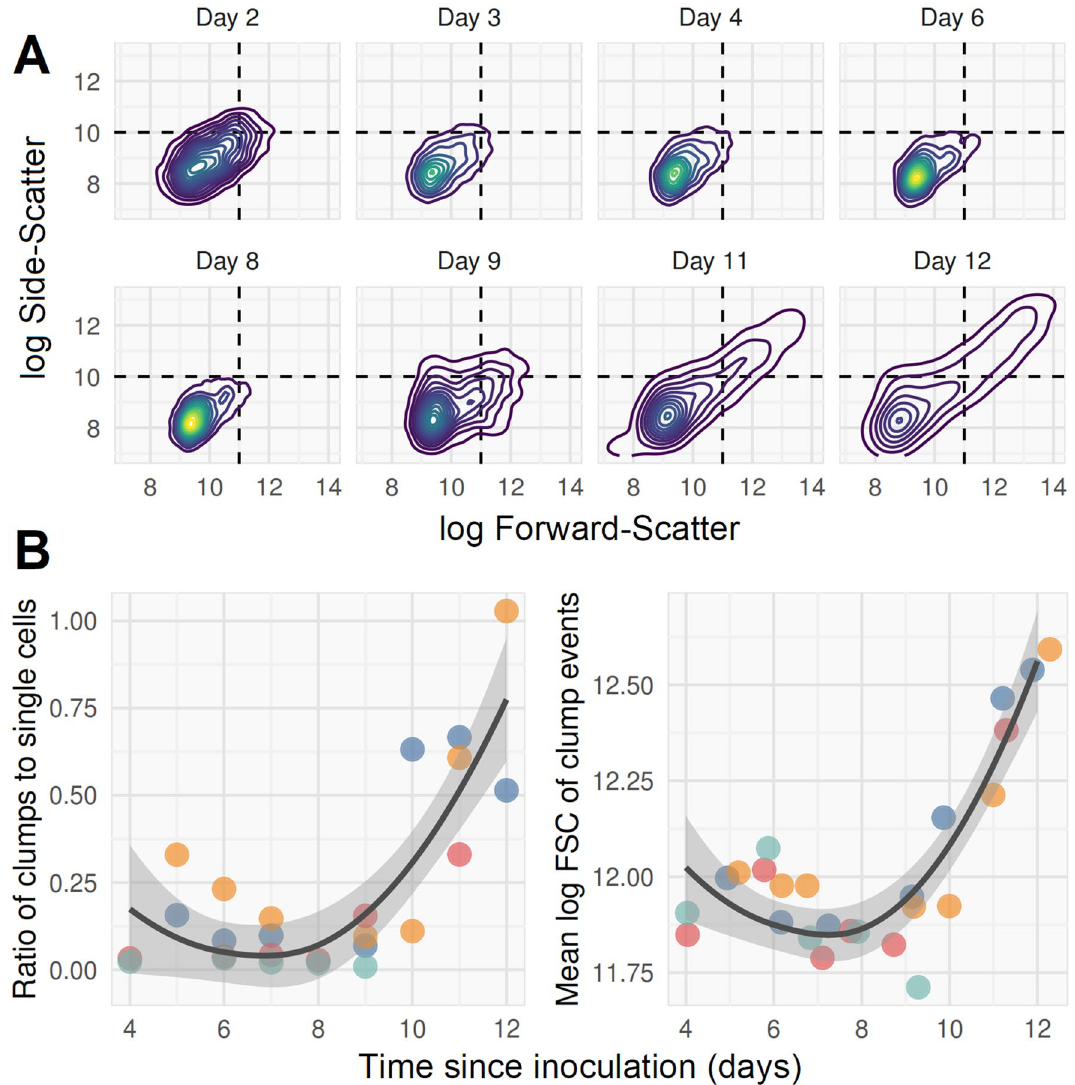
Figure 4. Clumps which are resistant to disruption by emulsification eventually emerge in late log-phase cultures. ( A ) M. bovis BCG culture in 0.15% v/v Tween80 7H9 with 150 rpm agitation and diluted tenfold in 0.15% v/v Tween80 PBS before bacilli were heat-killed and stained with SYBR-gold. Samples were needle- emulsified (12 passes through a double Luer lock-ended, 25 Gauge, 4-inch, micro-emulsifying needle) prior to FCM on BD Accuri C6; data acquisition with thresholds SSC > 1000 and FL1 > 1000. Timepoints are days post inoculation into pre-warmed broth from log phase starter culture. A long tail of clumps, extending into the upper-right quadrant of higher SSC and FSC, emerges from around day 9, at OD 600 ~ 0.3. Clumps were defined as events with SSC and FSC values greater than 10-log and 11-log (events in upper right quadrant of plots). Density distributions shown are derived from 5000 recorded events in each plot; initial starter cultures are a mixture of single cells and clumps (still visible on day 2 plot); early exponential growth is predominantly in the single cell population; later (after day 8) growth is predominantly of clumps. ( B ) Clumps and single cells quantified by flow cytometry (four independent replicates of data represented by A; replicates are shown with different colours). Emulsification appears able to disrupt clumps until late log phase (~ day 8), when both the ratio of clumps to single cells and size (approximated by mean FSC) of clumps rise rapidly. Line of best fit with 95% confidence interval band is a LOESS regression line ignoring dependence by CFU counts after needle emulsification were determined in parallel (Fig. 6). In all culture growth phases (lag, log, stationary), the HK cell count was greater than CA + , SG + , or CFU counts (Fig. 7A), and was accepted as a total cell count. During log-phase, most cells were CA + and colony forming, with SG + cells constituting a minority sub-population (Fig. 7B–D). When entering stationary phase, CA + and CFU counts started to fall, with a simultaneous rise in SG + cells, which subsequently became the dominant subpopulation (Fig. 7B–D).